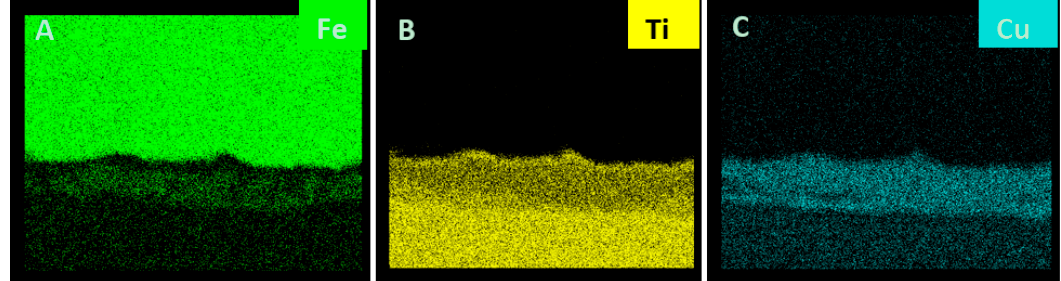
Figure 7. EDS maps of Ti–6Al–4V and SDSS joint bonded at 850 °C for 45 min with 25 µm Cu foil. EDS mapping of elements ( A ) iron, ( B ) Titanium, and ( C ) Copper.